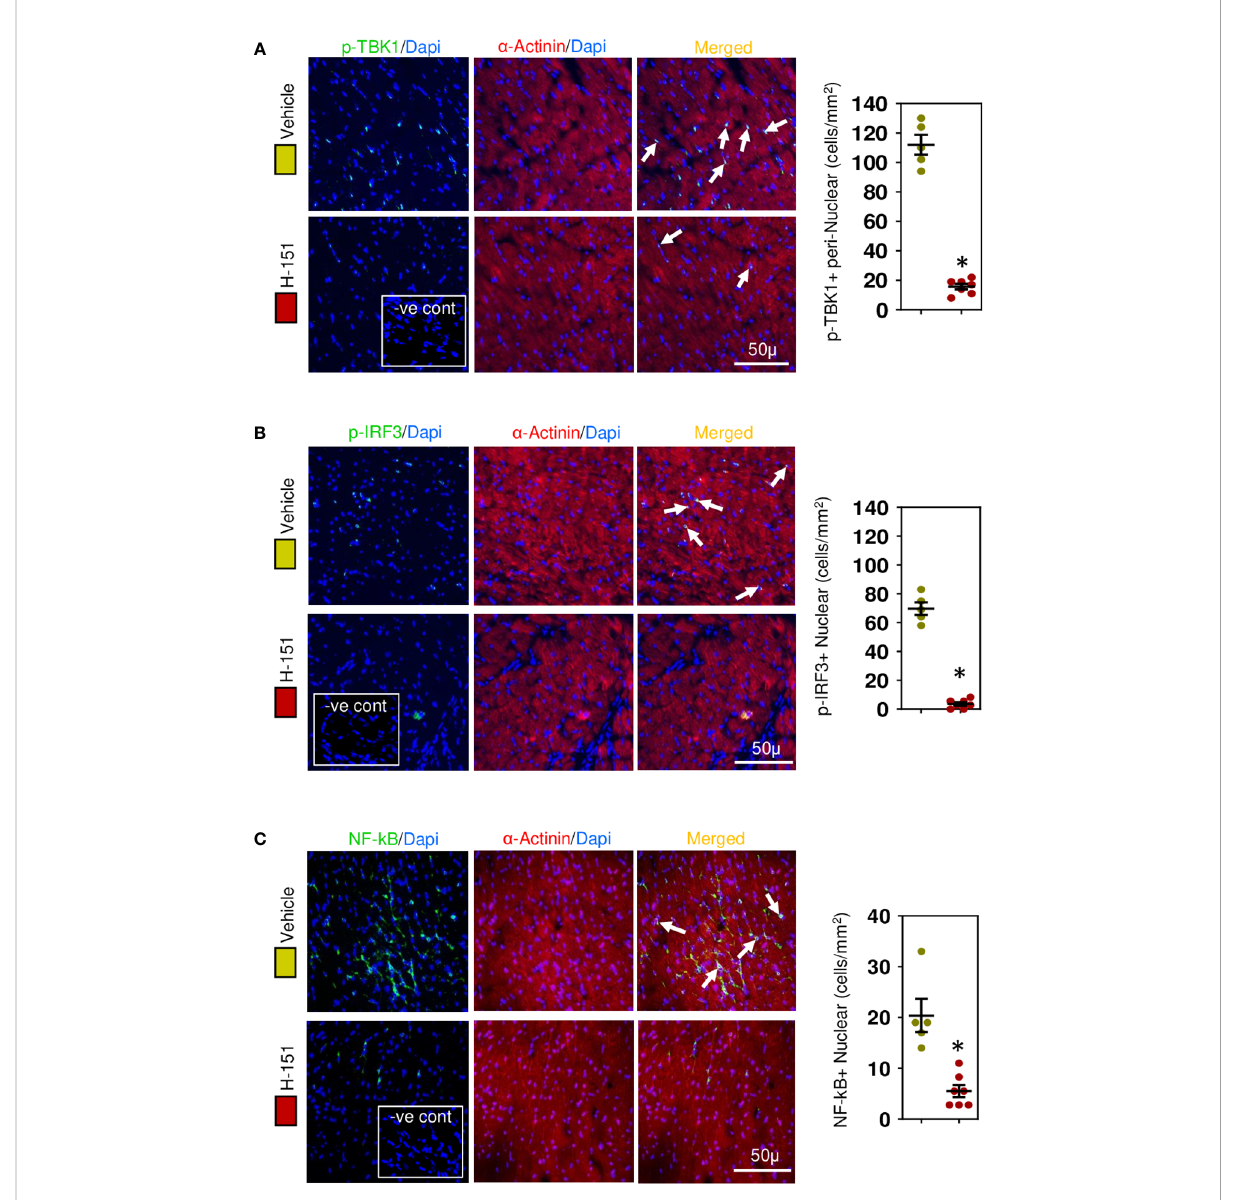
FIGURE 7 STING-IRF3-NF ĸ B signaling cascade is activated in cardiomyocytes during hypertensive fi brosis in TAC mice. (A) PhosphoTBK is increased in cardiomyocytes during fi brosis and prevented by H-151. (B) Nuclear phosphoIRF3 is increased in cardiomyocytes during fi brosis and inhibited by H-151. (C) Nuclear accumulation of NF- ĸ B(p65) is increased during fi brosis and inhibited by H-151. Results are means ± SEM with small circles represent data from individual mice. n=5-7/group. -ve control; no primary antibody control, scale bar represents 50µm. *P< 0.05 using two tailed Student ’ s t-test, comparing to